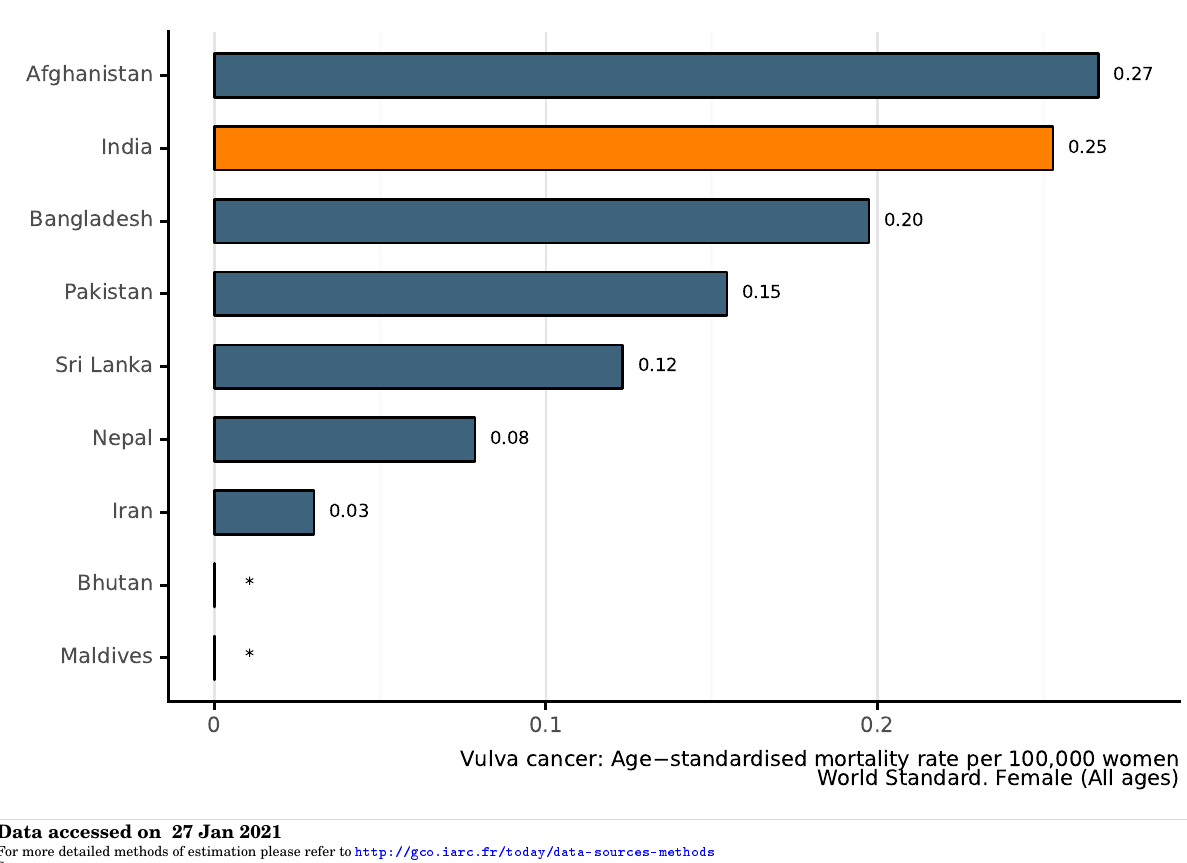
Figure 113: Age-standardised mortality rates of vulva cancer of India (estimates for 2020)